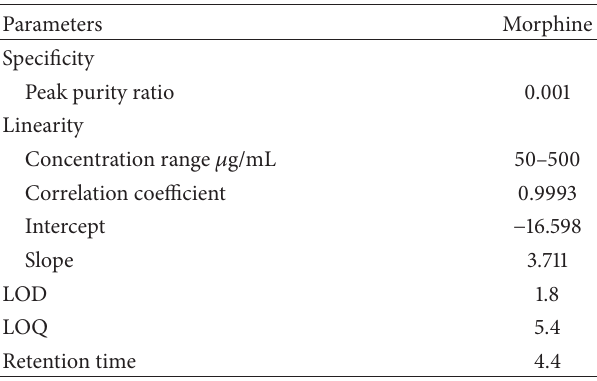
Table 1: Results obtained from testing different parameters during validation of the analytical